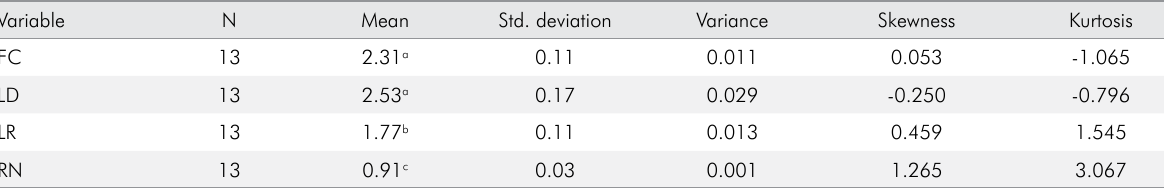
Table 3. The descriptive statistics for Brittleness Index ( μ m -1/2 ) across the materials type.